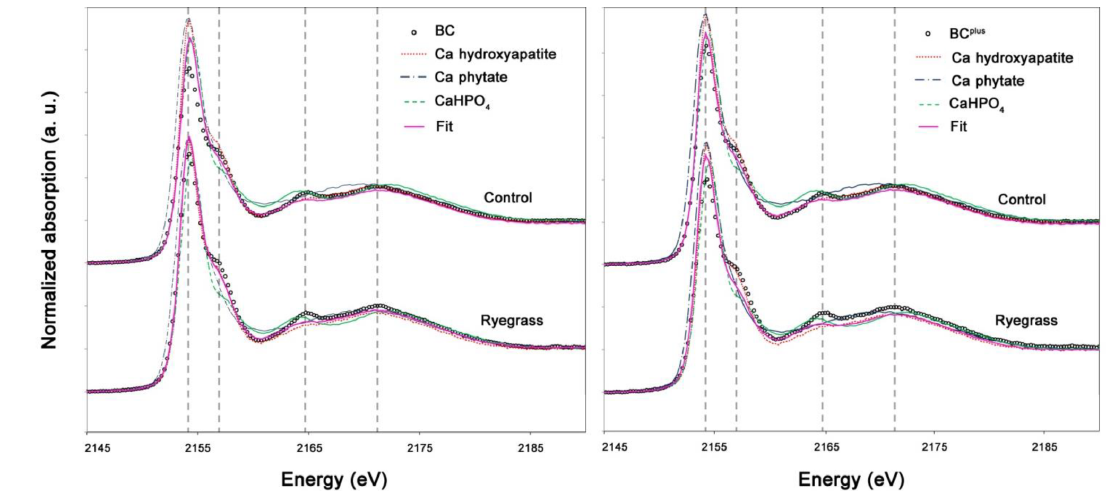
Figure 2. P K -edge XANES spectra of BC and BC plus particles before (control) and after 230 days of ryegrass cultivation compared to the reference compounds selected by the LCF